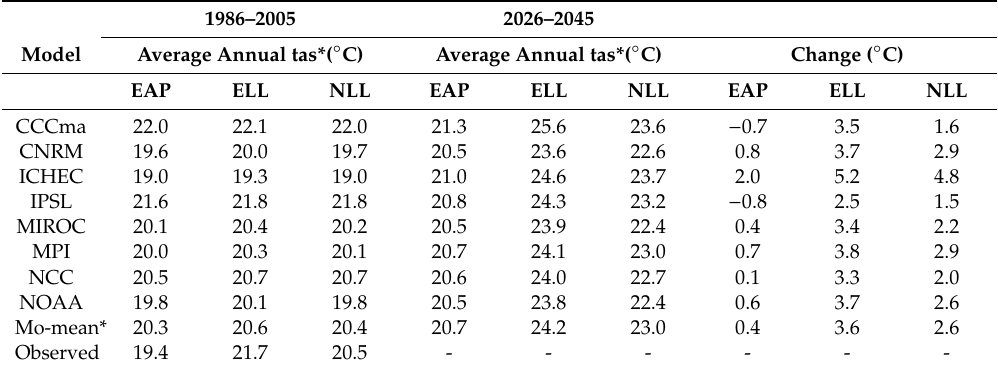
Table 4. Changes in annual temperature (2026–2045).